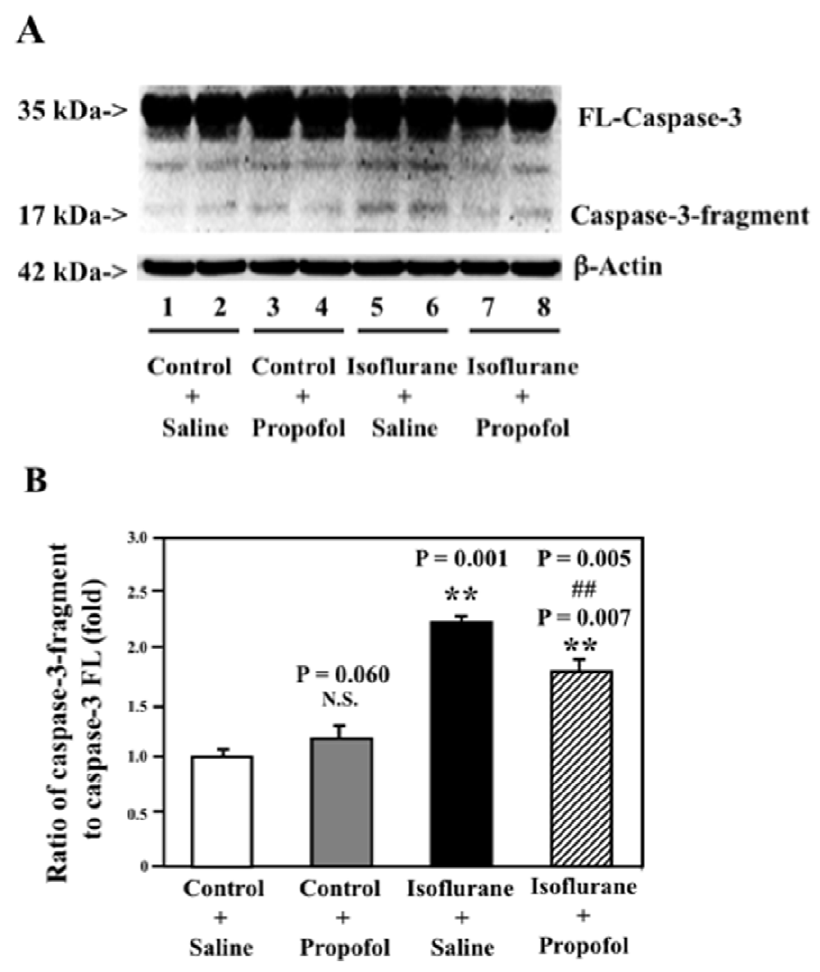
Figure 1. Propofol attenuates the isoflurane-induced caspase-3 activation in H4-APP cells. A. Treatment with 2% isoflurane (lanes 5 and 6) induces caspase-3 activation as compared to the control condition (lanes 1 and 2). The treatment of propofol alone (lanes 3 and 4) does not induce caspase-3 activation as compared to the control condition (lanes 1 and 2). However, propofol treatment (lanes 7 and 8) attenuates the 2% isoflurane- induced caspase-3 activation as compared to 2% isoflurane alone (lanes 5 and 6) in the H4-APP cells. There is no significant difference in amounts of b -Actin in the H4-APP cells following these treatments. B. Quantification of the Western blot shows that 2% isoflurane (black bar, ** P=0.001) induces caspase-3 activation as compared to control condition (white bar). The propofol treatment alone (gray bar) does not induce caspase-3 activation as compared to control condition (white bar). However, two-way ANOVA shows that the propofol treatment (net bar, ## P=0.005) attenuates the isoflurane-induced caspase-3 activation. (N=3).